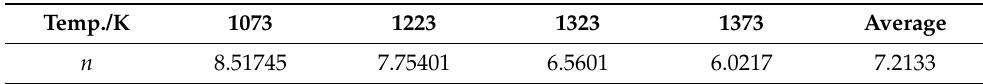
Figure 7. The relation curve of ln [ sinh ( ασ )] − ln ( 1/ T ) . Table 2. The values of n under different deformation temperatures. Temp./K